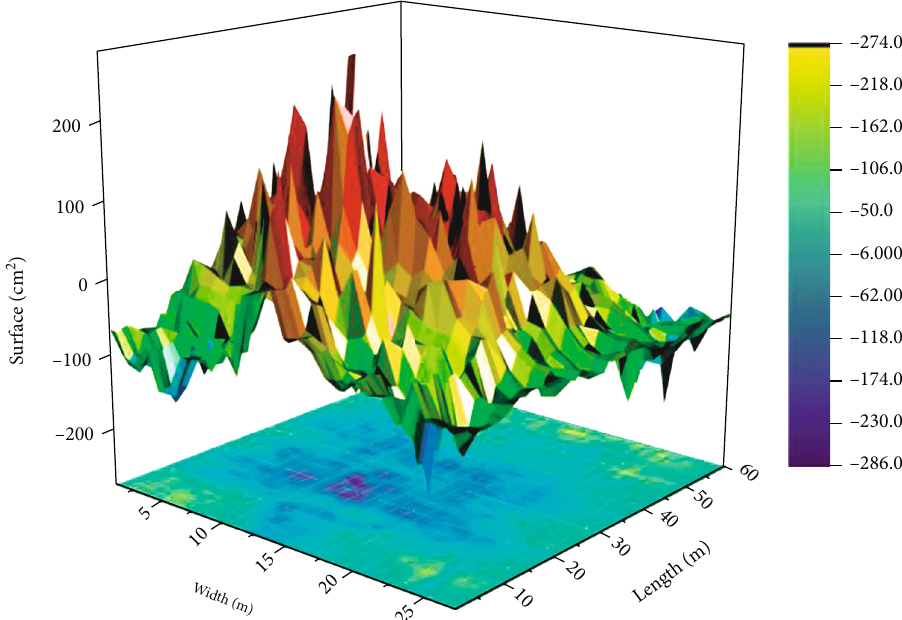
Figure 6: Intra- and intergroup evaluations and corresponding di ff erences in cervical spine mobility measured with the depth camera-VR device